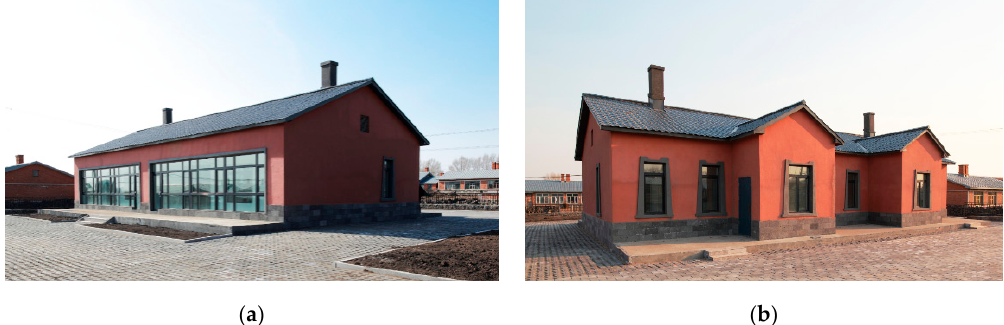
Figure 15. Outside views of the demonstration house. ( a ) South facade; ( b ) north facade.